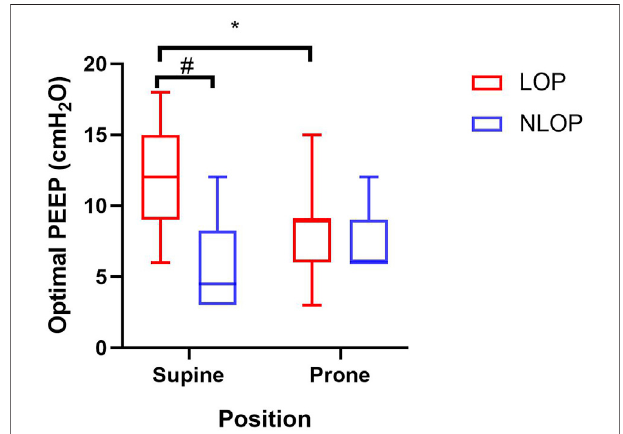
FIGURE 4 | Electrical impedance tomography (EIT)-estimated optimal positive end-expiratory pressure (PEEP) in supine and prone positions. # p < 0.05comparedwiththeLOPgroup.* p < 0.05comparedwithsupineposition.